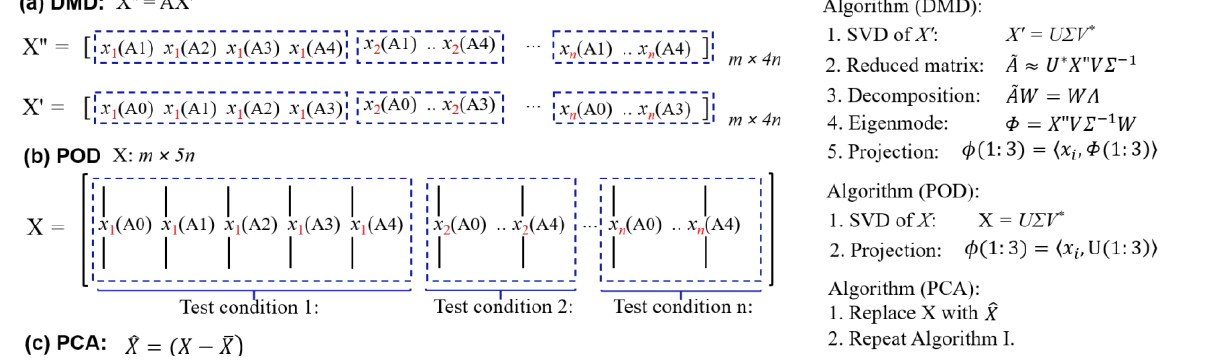
Figure 2. Schematic of feature extraction using different classification algorithms: ( a ) DMD, ( b ) POD, and ( c ) PCA. Each aerosol image is expressed as a single-column vector. The parameter m is the size of the image (e.g., a 600-by-600 image gives m = 360,000), and n is the number of tests with each model.